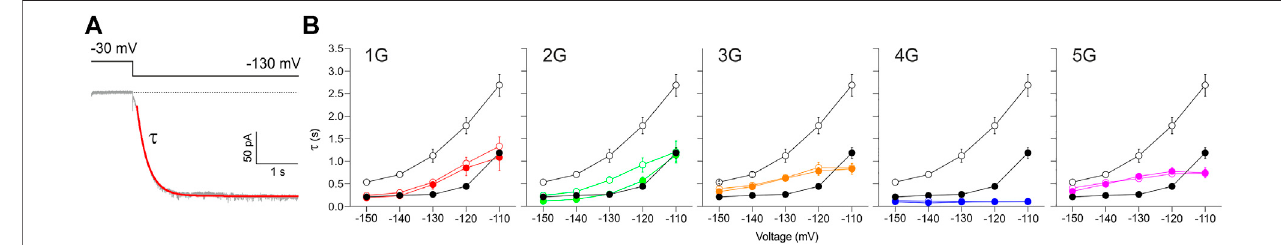
FIGURE 7 | Effect of inserted glycines on activation kinetics. (A) Example trace for 1G illustrating a fi tted exponential curve (red) to obtain the time constant of activation, τ ,byusing Eq. Error!Digit expected (B) Plots ofactivationtime constantsversus voltage forall fi vemutant constructs incomparison toHCN2 (black lines and symbols in all fi ve panels). Empty symbols represent cAMP-free condition, fi lled symbols represent recordings at 10 µM cAMP. Glycine-induced uncoupling interrupts the reciprocal feedback from VSD to CNBD.